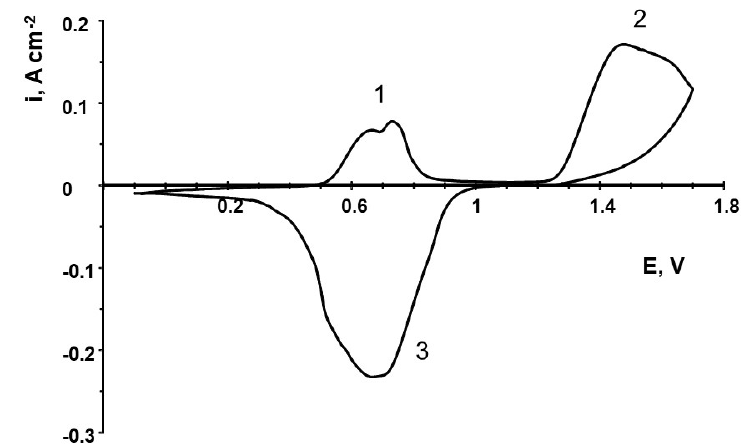
Figure 7. Voltammetry of the H 2 − KI cell measured at 25 °C with a voltage scan rate of 2 mV s − 1 and a H 2 flow rate of 50 mL min − 1 . The porous carbonaceous electrode was filled with stagnant 0.25 M KI-1 M H 2 SO 4 .